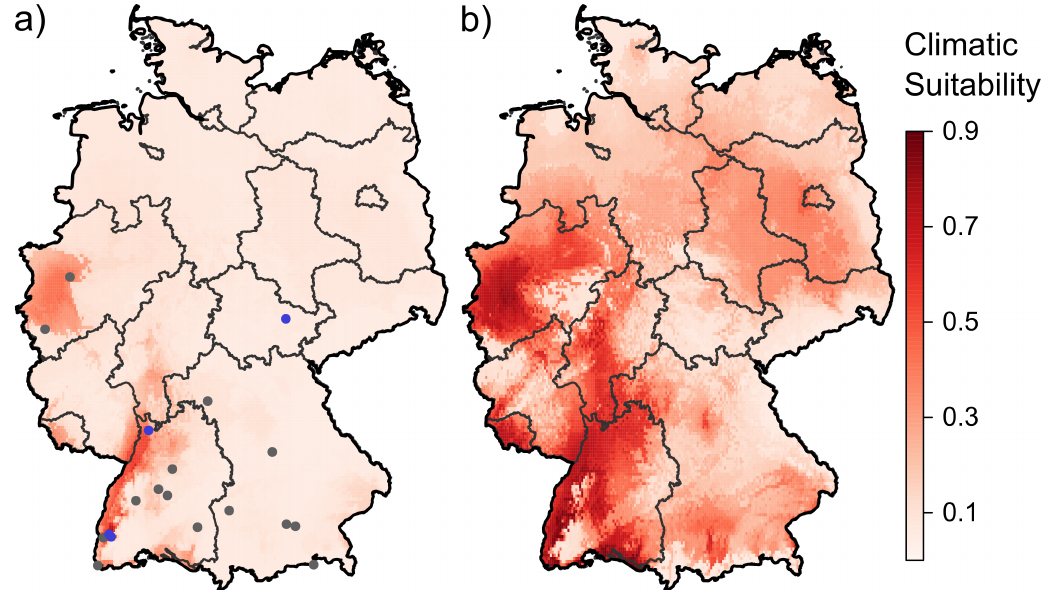
Figure 2. ( a ) Relative climatic suitability for the establishment of Aedes albopictus in Germany. Circles: high-precision occurrence records derived from the literature for both single introduction events (grey) and established (overwintering) populations (blue); only the latter were used for modelling. ( b ) Projected future suitable climates for the establishment of Aedes albopictus in Germany (near future 2021–2040, climate model mpi-esm-lr, climate scenario RCP 8.5). ( a , b ) global climatic dataset worldclim with spatial resolution of 2.5 arcmin ( ≈ 5 km). Lines delineate level-2 administrational units (federal states) of